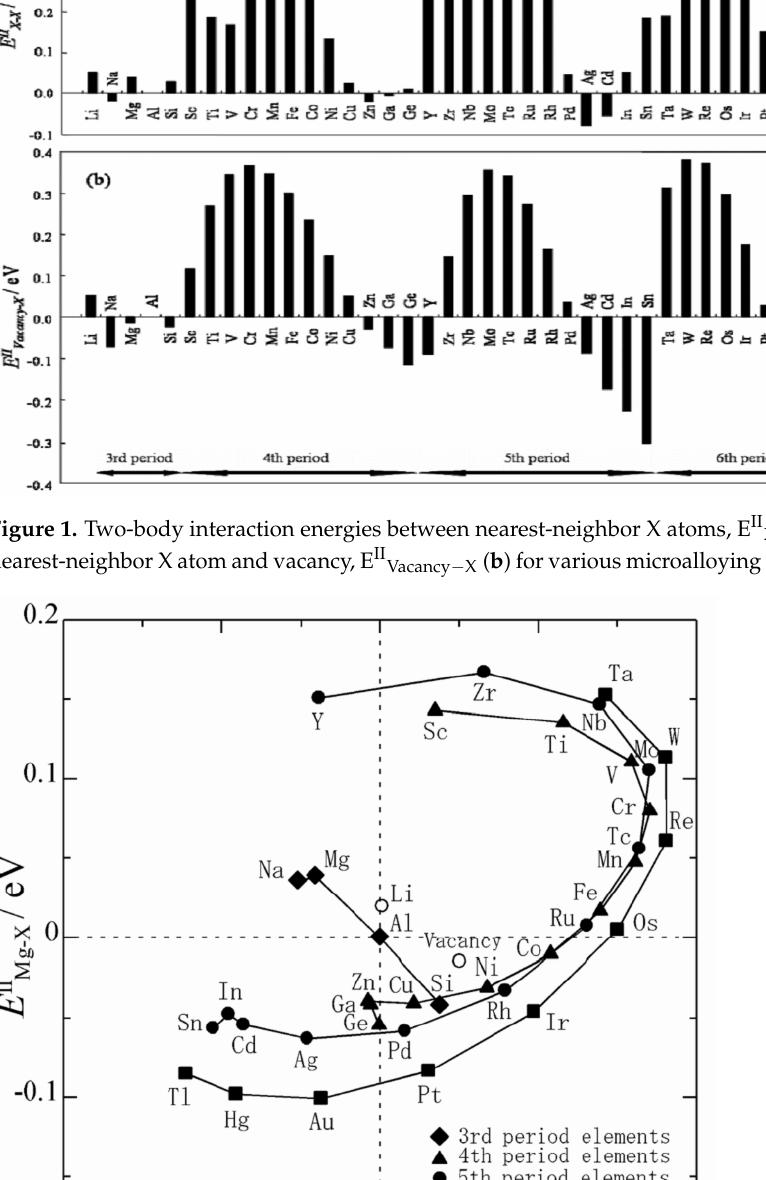
Figure 2. Two-body interaction energies between Mg-X atoms (E II Mg − X ) and between Cu-X atoms (E II Cu − X ) in Al-Mg-Cu alloys [18].